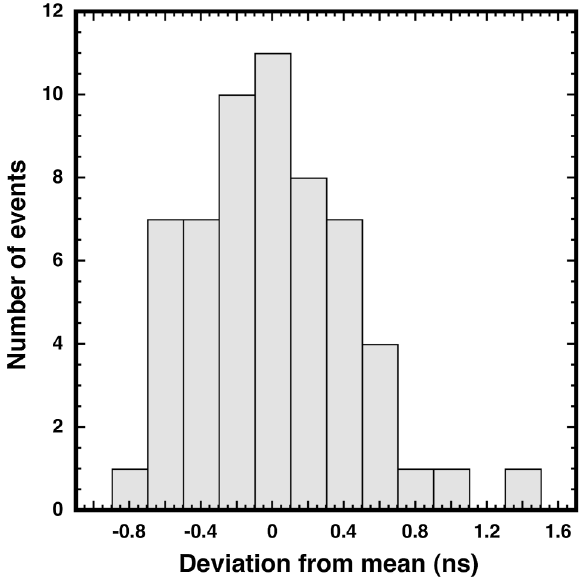
FIG. 14. Histogram of pulse generator run time relative to the laser photodiode signal on full system shots of the Z facility. The 1 standard deviation in the timing is 430 ps. This includes digitizer uncertainty, which is of the order of 140 ps, at 200 ps per point sampling rate.